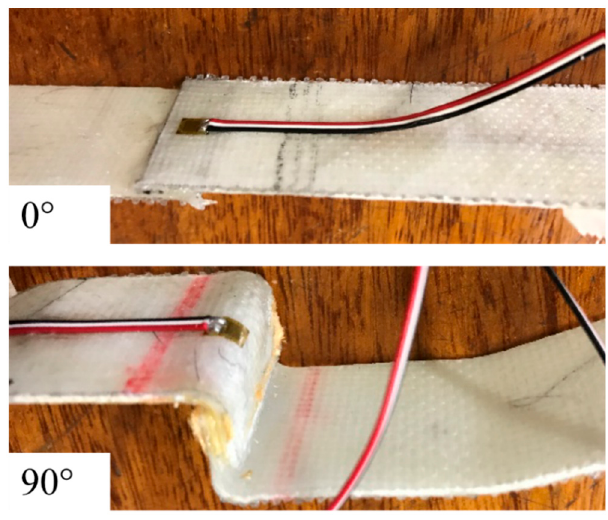
Figure 5. Images from the test samples showing the location of the strain gauge used to record the max strain values for the 0° and 90° joints.